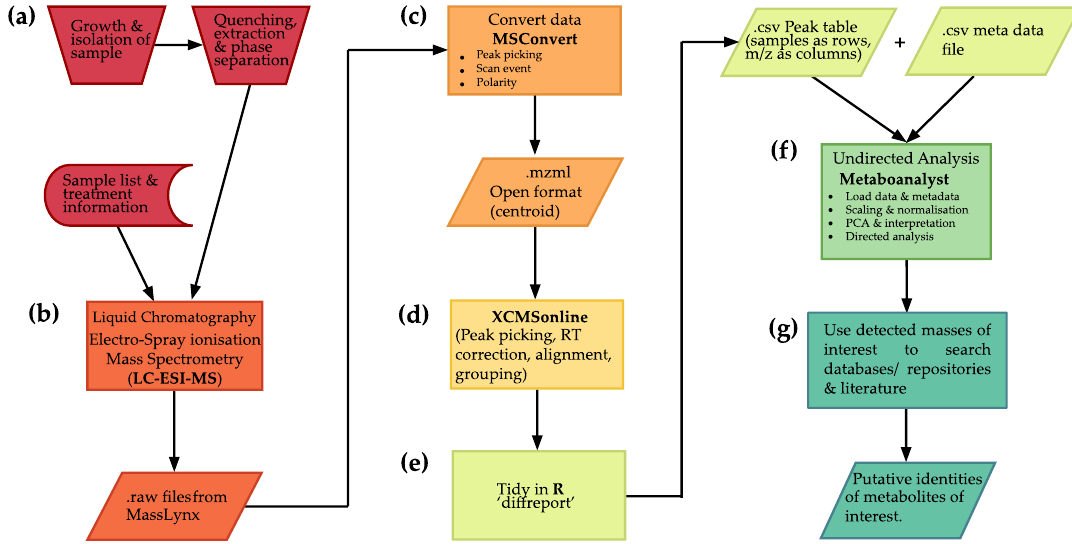
Figure 1. Workflow diagram for processing and analysis of untargeted LC-MS metabolomics data. ( a ) sample selection and preparation. ( b ) Mass spectrometry analysis of samples. ( c ) Conversion of data to open format. ( d ) Data pre-processing and ( e ) production of a feature matrix with experimental information included. ( f ) Statistical analysis for selection of features of interest and ( g ) identification of features of interest by comparison with literature and existing metabolite databases.